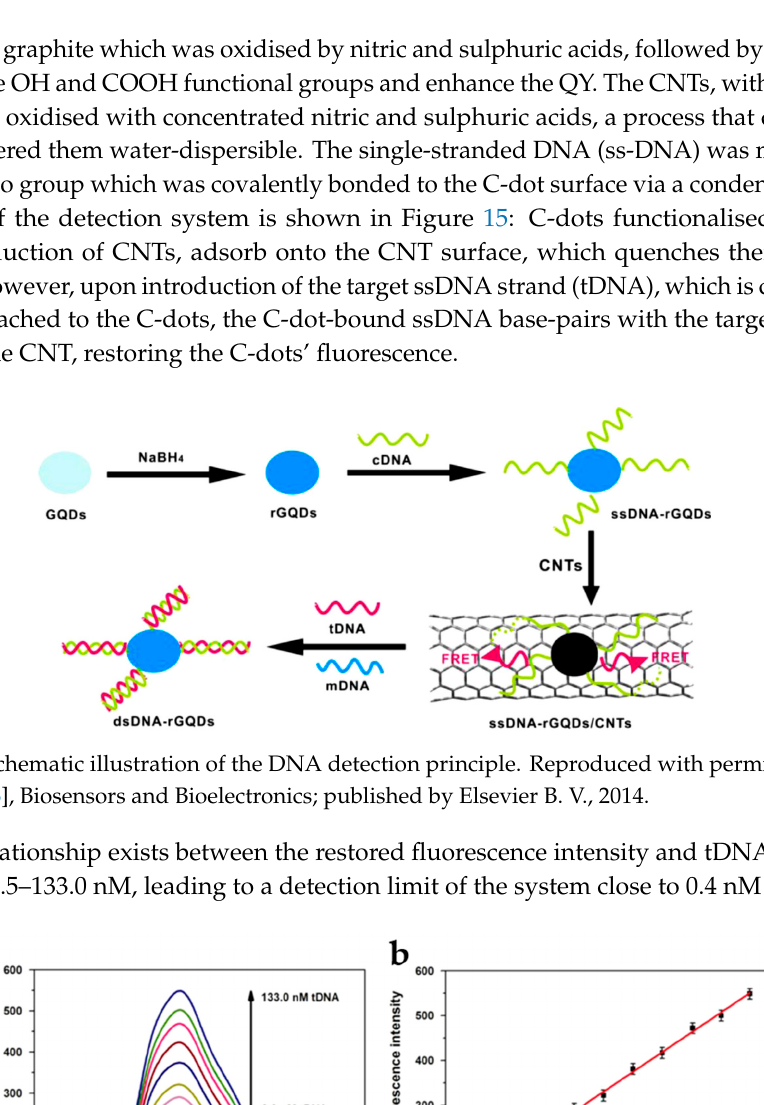
Figure 14. ( a ) Chinese character written in blood; ( b ) the bloodstained fabric after washing; ( c ) the washed fabric sprayed with C-dots and seen under natural light; ( d ) the C-dot-sprayed fabric seen under 460–490 nm light, showing darkening where traces of blood remain. Reproduced from reference [75] with permission from The Royal Society of Chemistry.